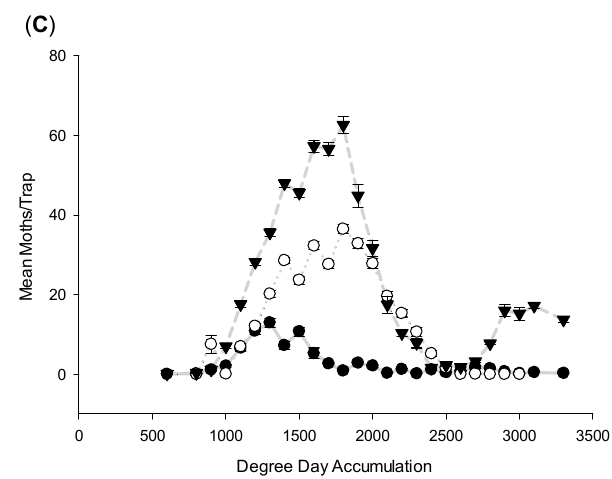
Figure 1. Flights of cranberry fruitworm (CFW), sparganothis fruitworm (SFW), and blackheaded fireworm (BHFW) in the ( A ) southern; ( B ) central; and ( C ) eastern growing regions of Wisconsin.